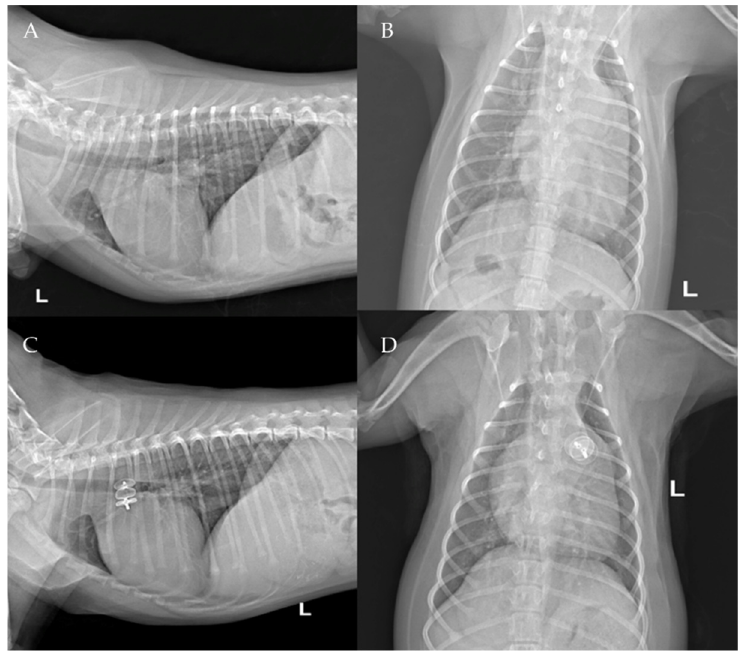
Figure 8. Pre-procedure ( A , B ) and post-procedure ( C , D ) left lateral and dorso-ventral thoracic radi- ographs of Case 1. L: left; R: right.